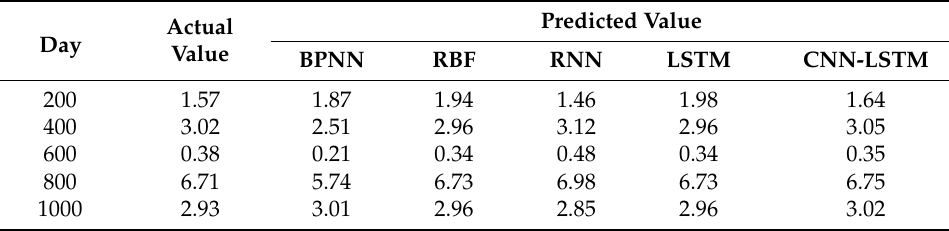
Table 5. Comparison of predicted values and real values of typical single wells.